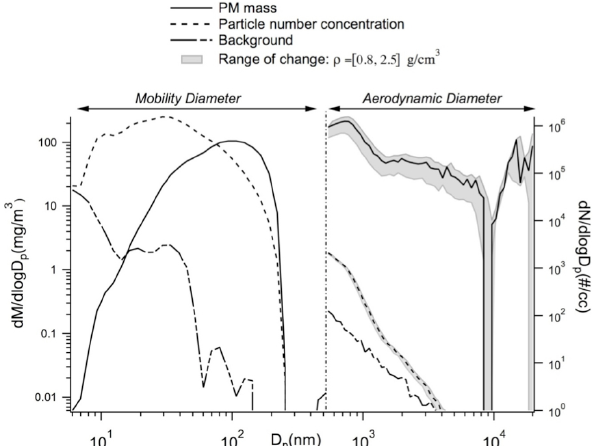
Fig. 6. Particle number and mass size distributions corresponding to a typical burn, also the background concentration.